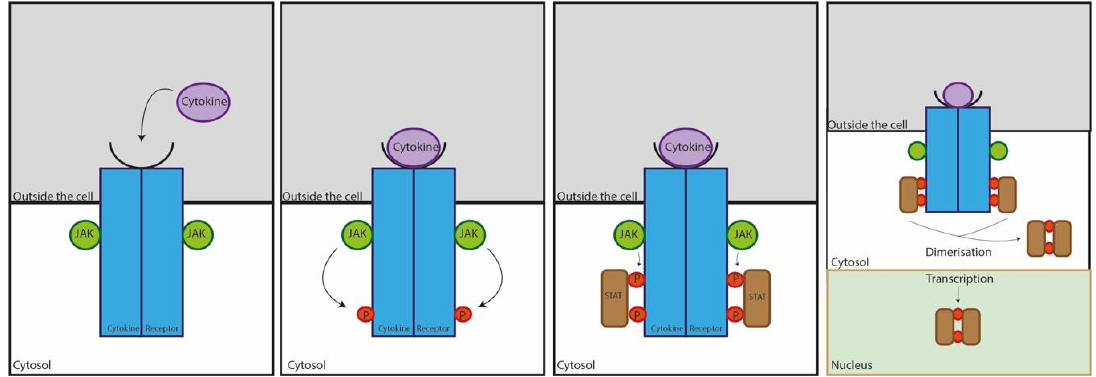
Figure 1. Janus kinase (JAK) / signal transducer and activators of transcription (STAT) pathway of cytokine action. Cytokines bind to receptors embedded in the cell surface, triggering the activation of one or more JAKs. The JAK then phosphorylates the receptors, and when the STATs bind, they are phosphorylated by receptors. Once the STAT is phosphorylated, it acts on the transcription and translation of DNA within the nucleus to regulate gene expression. The cell will then induce a signalling pathway, upregulate or downregulate more cytokines, or activate other cell types [26,27].